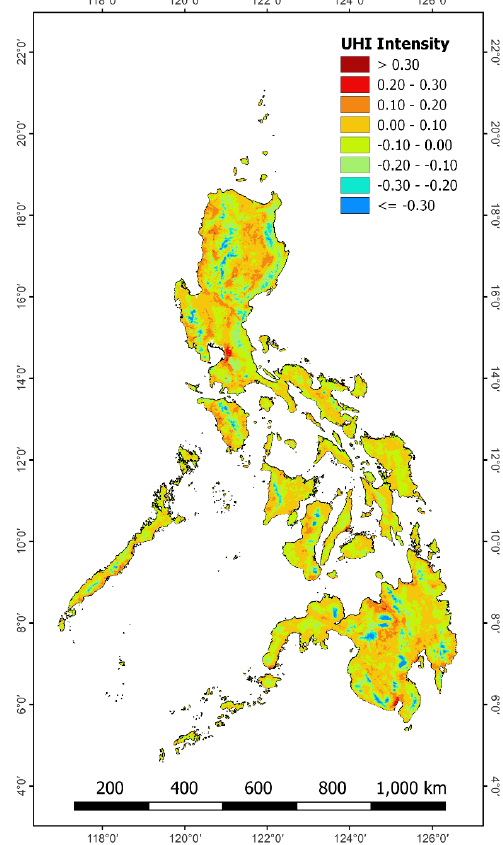
Figure 3. The UTFVI-based UHI output revealed that almost half of the total area of the country is experiencing extreme heat. The UHI effect is more prominent in highly urbanized areas such as Metro Manila, Cebu City, and Cagayan de Oro.